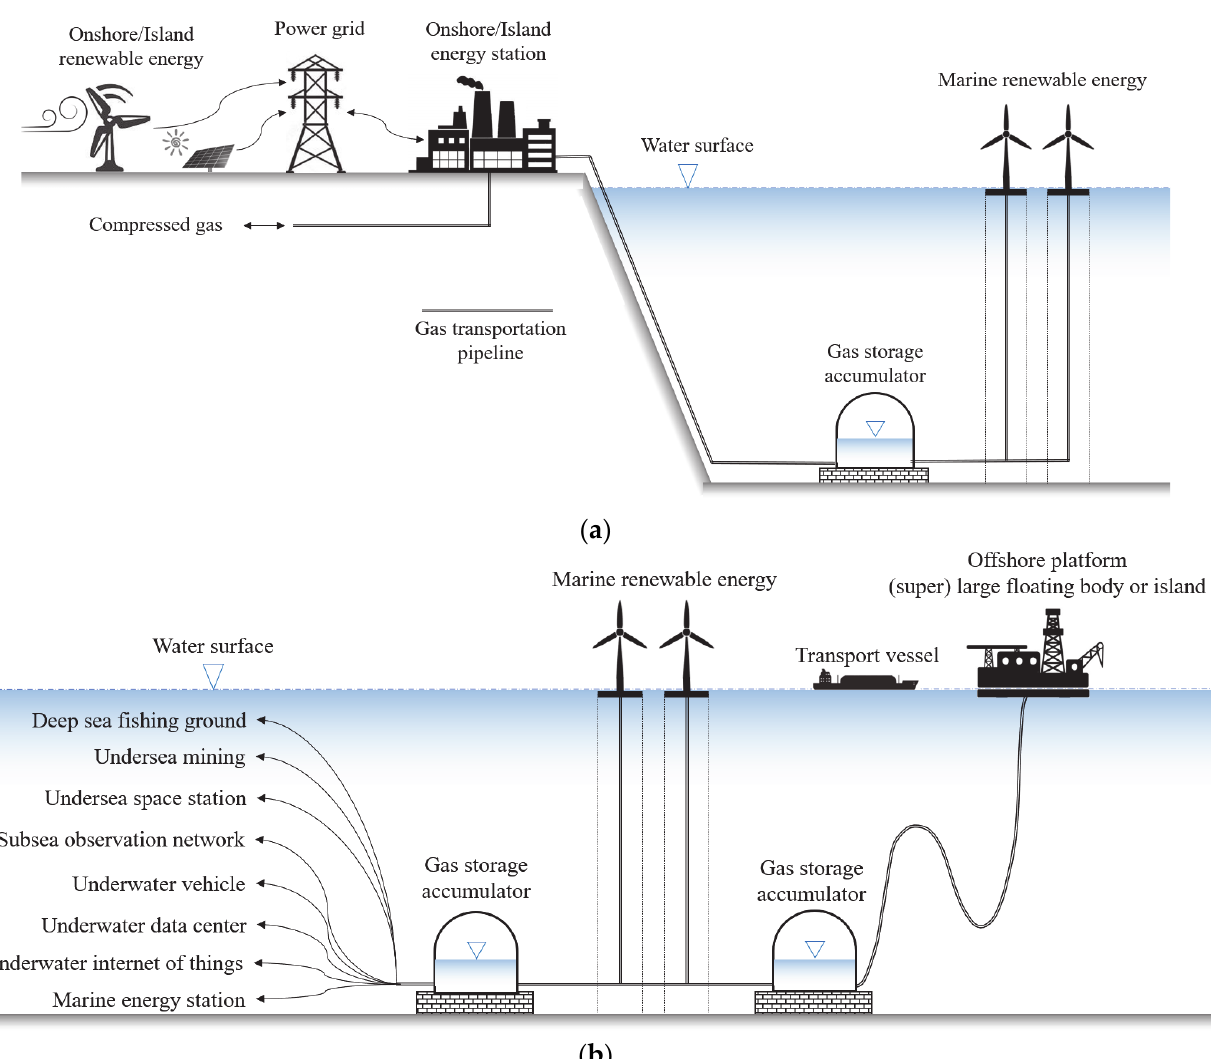
Figure 7. An integrated application mode of UWCGES. 6. Conclusions UWCGES is one of the most feasible solutions for large ‐ scale offshore energy stor ‐ age. Though facing many challenges, its potential has driven significant recent attention. Technical challenge considerations include: effective ballast anchoring, structural stabil ‐ ity under complex and cyclic loads, safety under the impacts of falling objects and gas